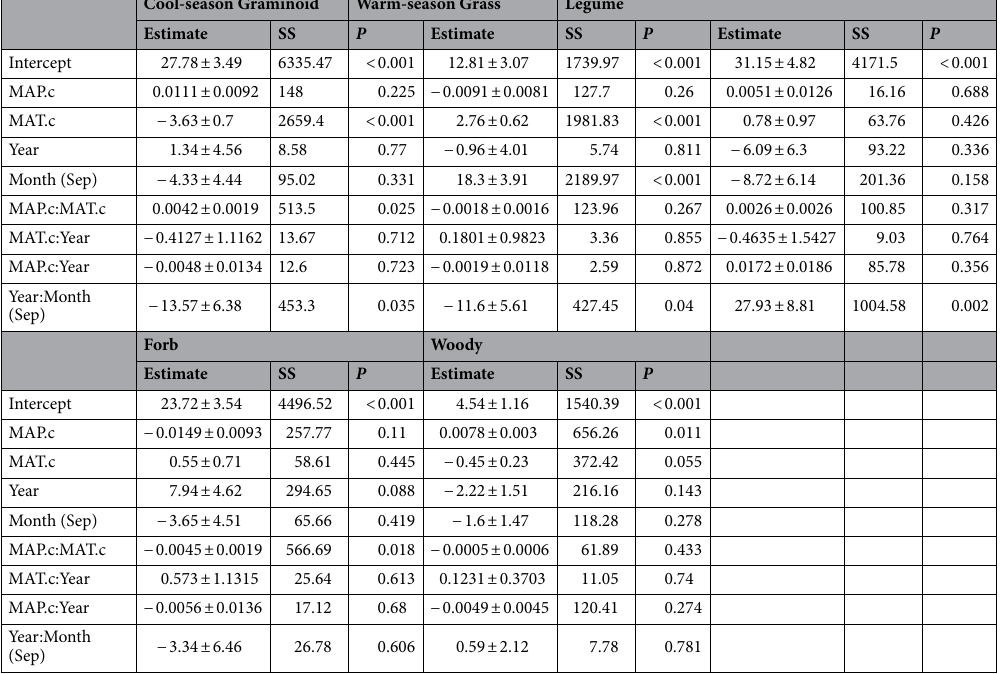
Table 3. Model results for comparing functional group abundance in bison diet for June and September between 2018 and